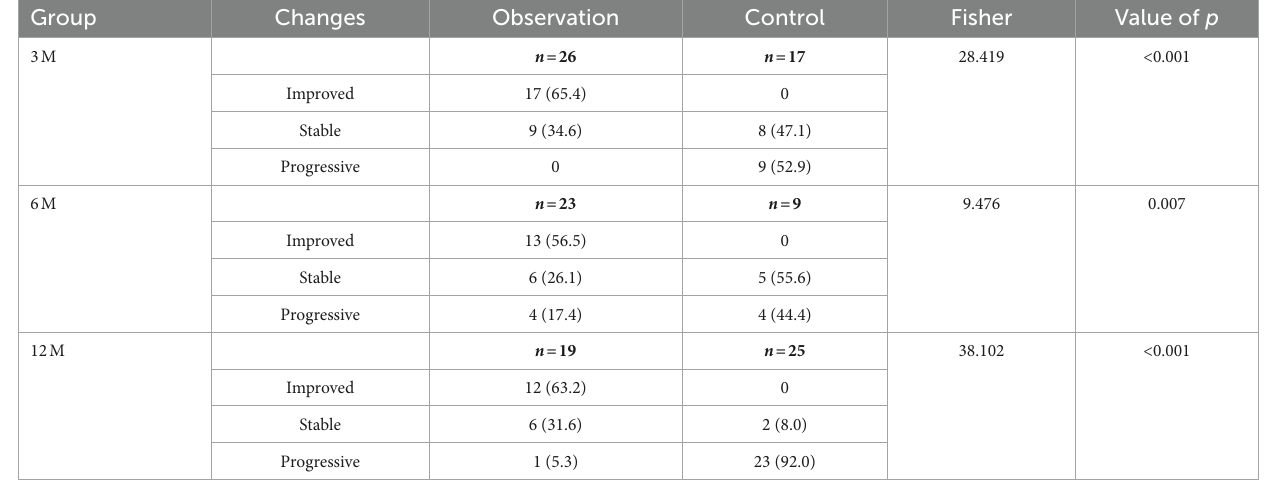
TABLE 2 Changes in HRCT features of the observation and control groups after treatment [ n (%)]. Group